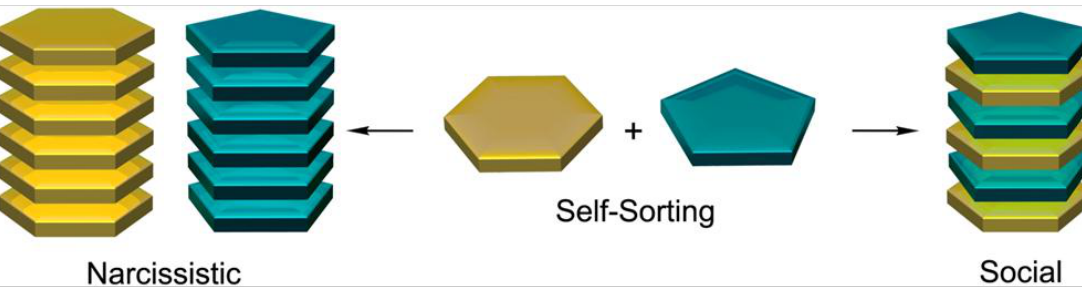
Figure 1. Narcissistic and social self-sorting phenomena in multicomponent